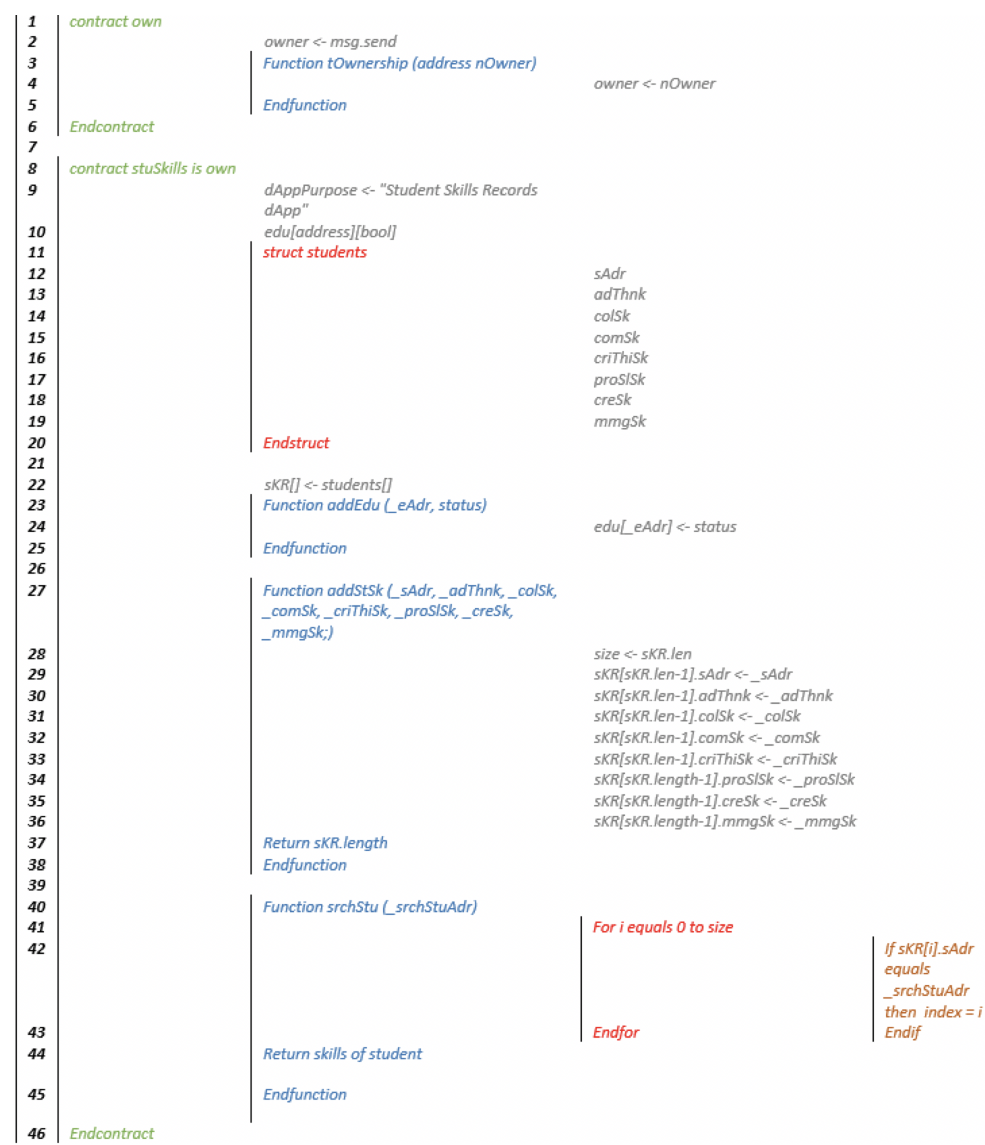
Figure 3. Pseudo code of skillsChain